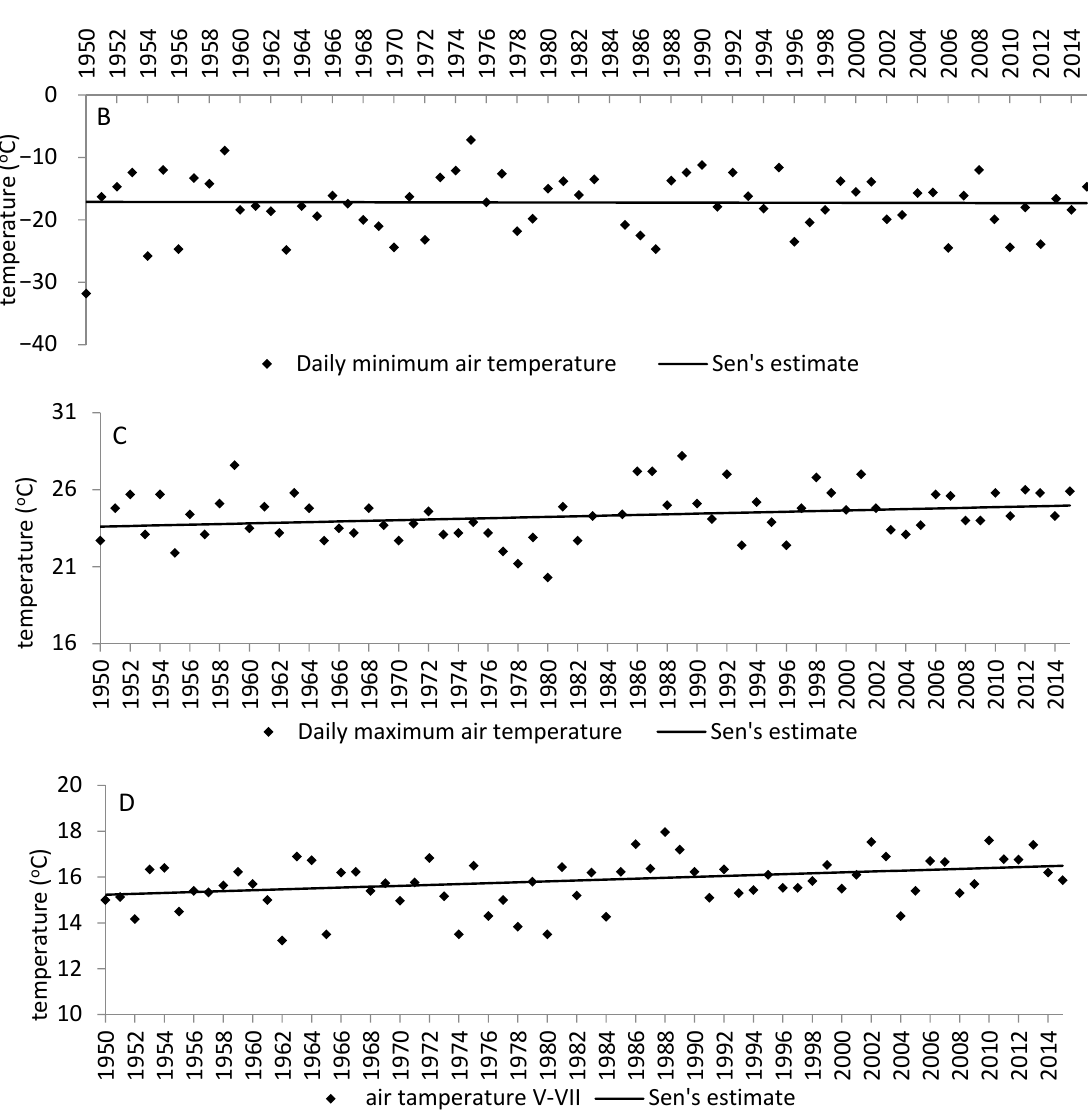
Figure 3. Annual average ( A ); daily minimum ( B ); daily maximum ( C ); average from May to July ( D ). Air temperature from 1950 to 2015 in Bialowieza.